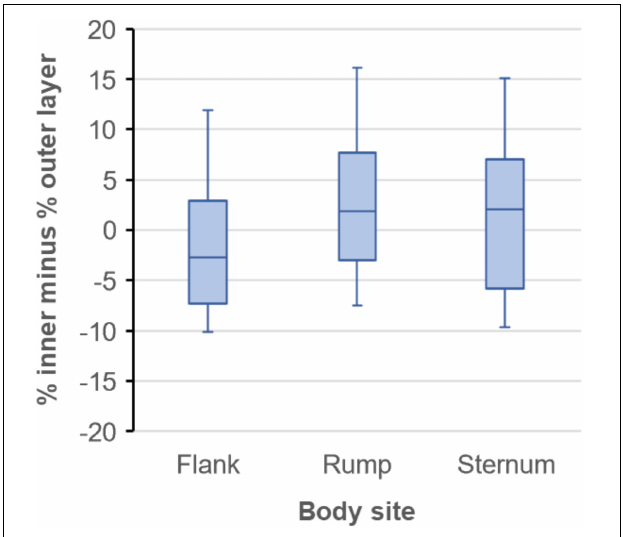
FIGURE 2 | Observed differences in percent lipid content between inner and outer blubber layers among three body sites of 15 lactating Pacific walruses in spring 2007 (plots indicate median, 25th and 75th percentile (box), and minimum and maximum (whiskers).